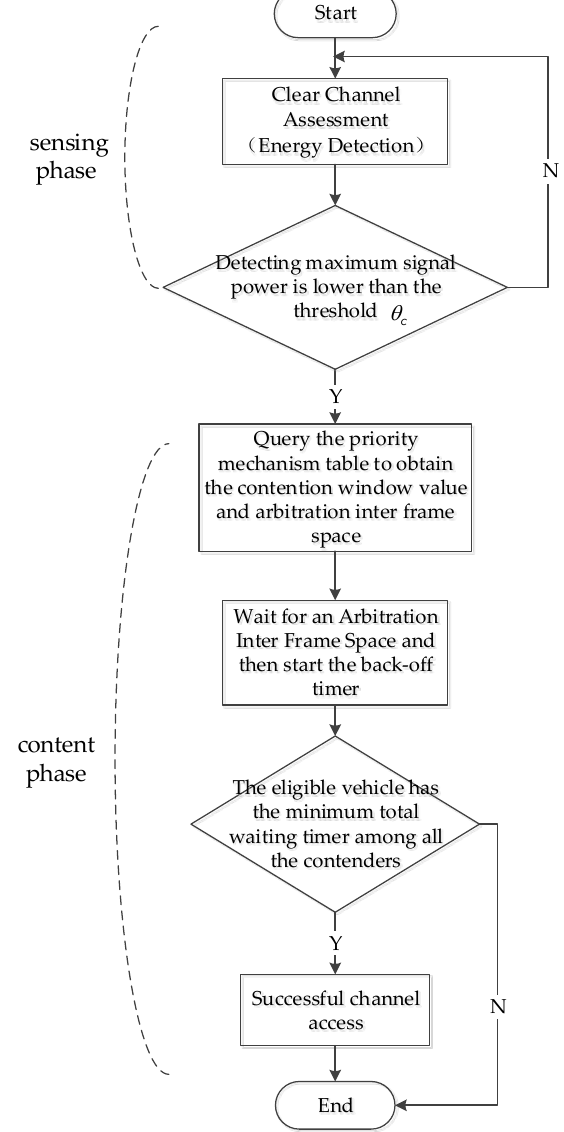
Figure 3. EDCA protocol flow chart.